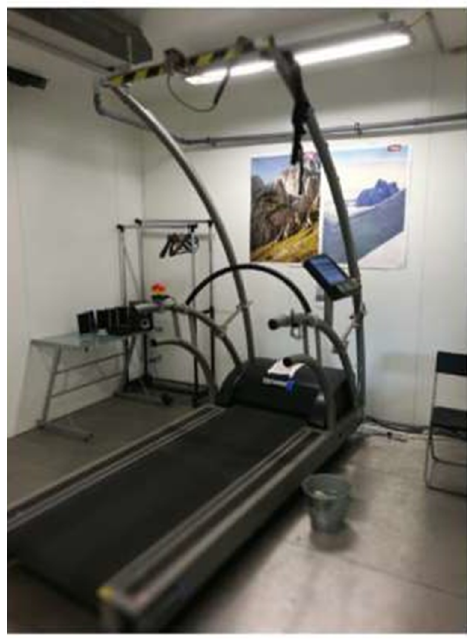
Figure 1. Interior view of the environmental chamber at the Department of Sport Science at the University of Innsbruck, Austria. Treadmill: h/p cosmos sports & medical GmbH, Nußdorf, Germany.